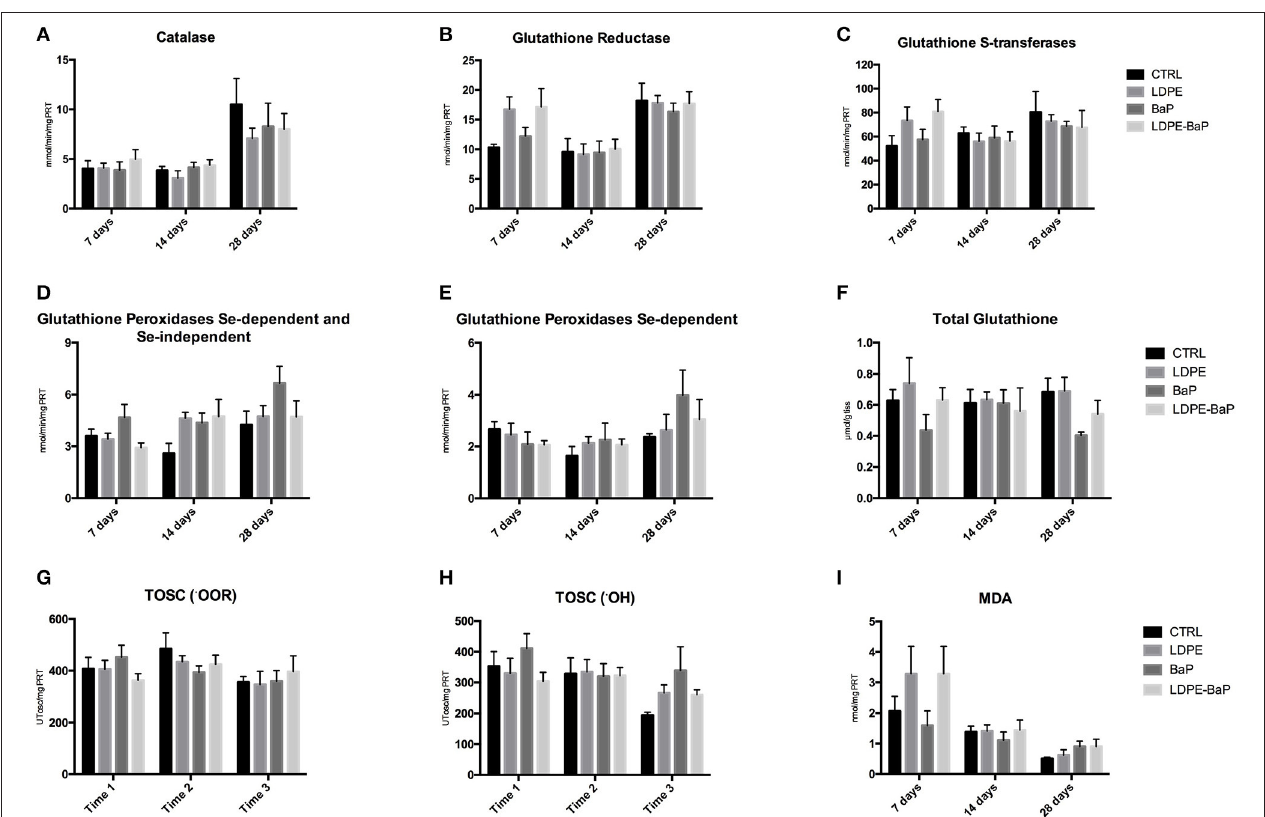
FIGURE 5 | Levels of catalase (A) , glutathione reductase (B) , glutathione S-transferases (C) , sum of Se-dependent and Se-independent glutathione peroxidases (D) , Se-dependent glutathione peroxidases (E) , total glutathione (F) , total oxyradical scavenging capacity (TOSC) toward peroxyl ( • OOR) radicals (G) , total oxyradical scavenging capacity (TOSC) toward hydroxyl ( • OH) radicals (H) , malondialdehyde (MDA) (I) in mussels exposed for 7, 14, and 28 days to various treatments (CTRL, control; LDPE, virgin low density polyethylene; BaP, benzo(a)pyrene alone; LDPE-BaP, benzo(a)pyrene-contaminated polyethylene). Data are expressed as mean values ± standard error, n = 4; different letters indicate significant differences between groups of means within the same time of exposure ( post-hoc Newman-Keuls